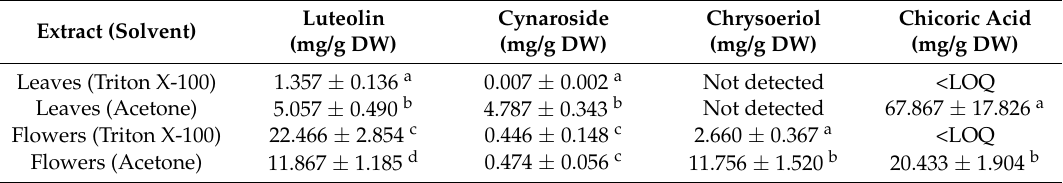
Table 6. Results of the phenols quantification in the Taraxacum officinale